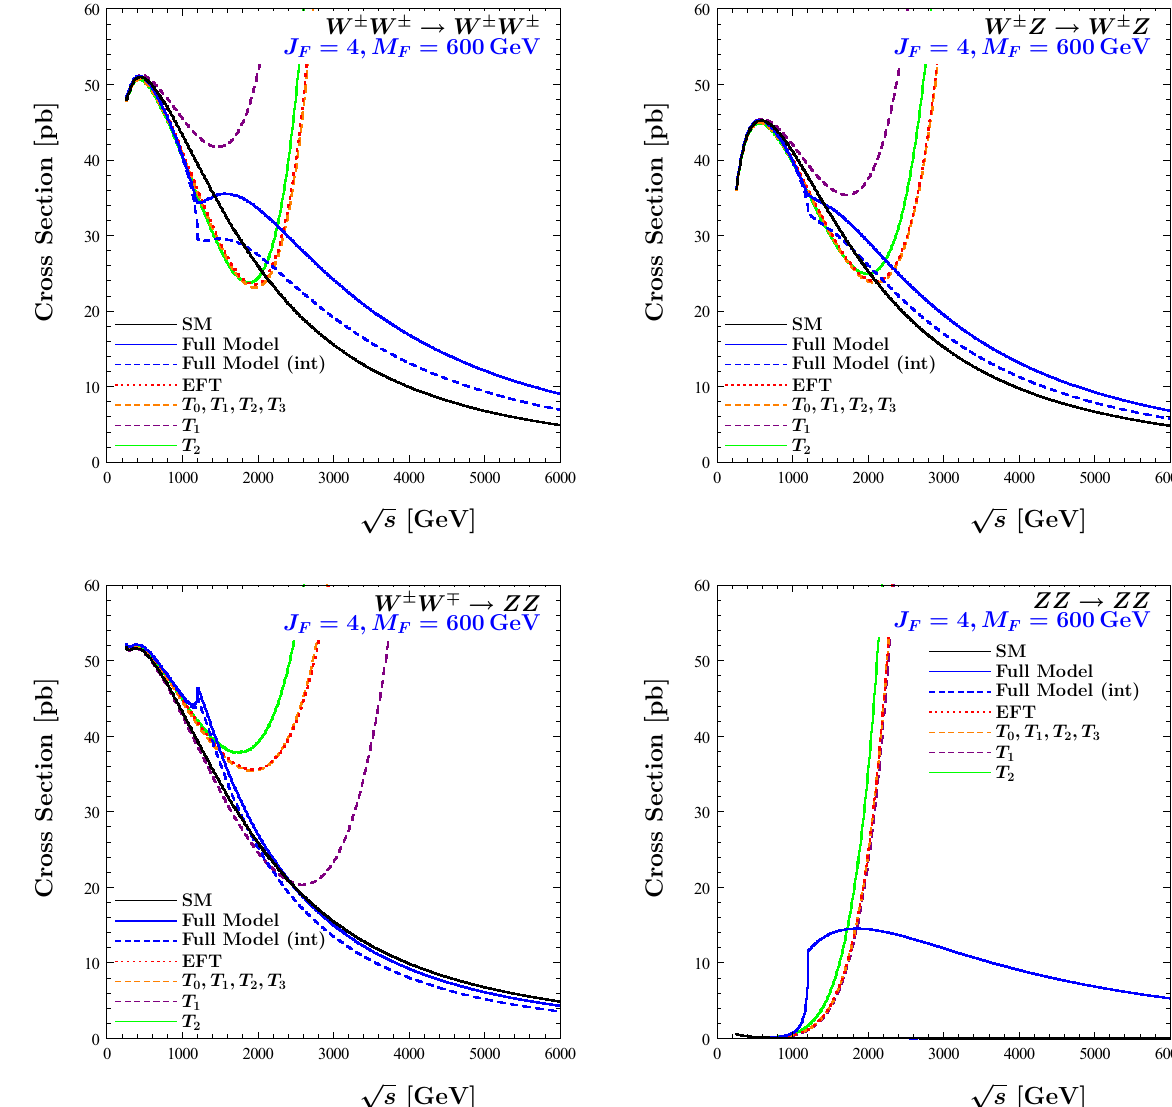
fermion nonet and in Fig.6 for a single scalar multiplet with J S =